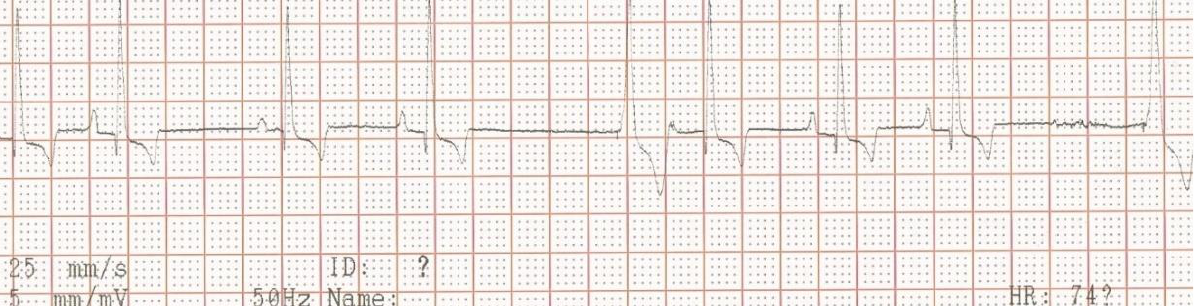
Figure 6. Surface electrocardiogram at the end of the first course of antibiotic therapy. Lead aVF shows sinus arrhythmia, where at the longer pauses a paced ventricular QRS-complex appears (VVIR pacing mode).